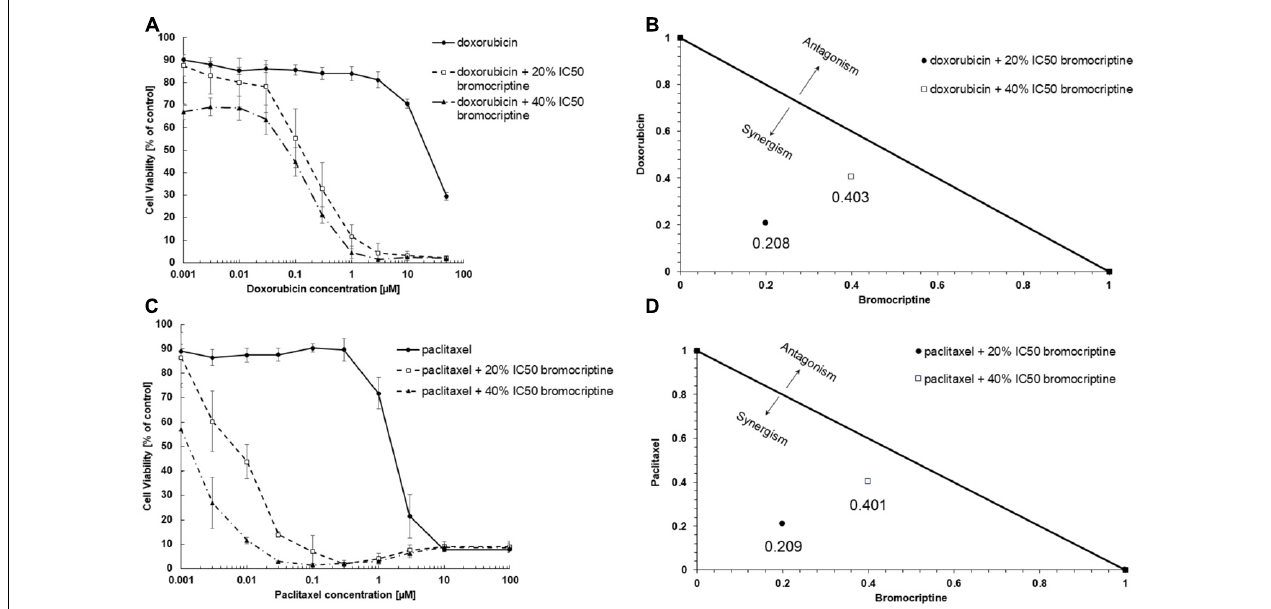
FIGURE 3 | Synergistic effects of bromocriptine with (A,B) doxorubicin or with (C,D) paclitaxel in CEM/ADR5000 cells as shown in (A,C) dose response curves and (B,D) dose-normalized isobolograms.